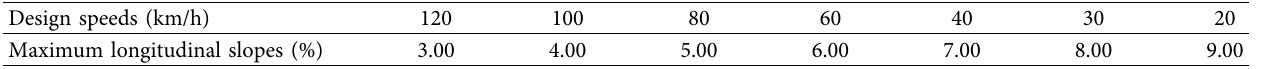
Table 4: Maximum longitudinal grades of highways.